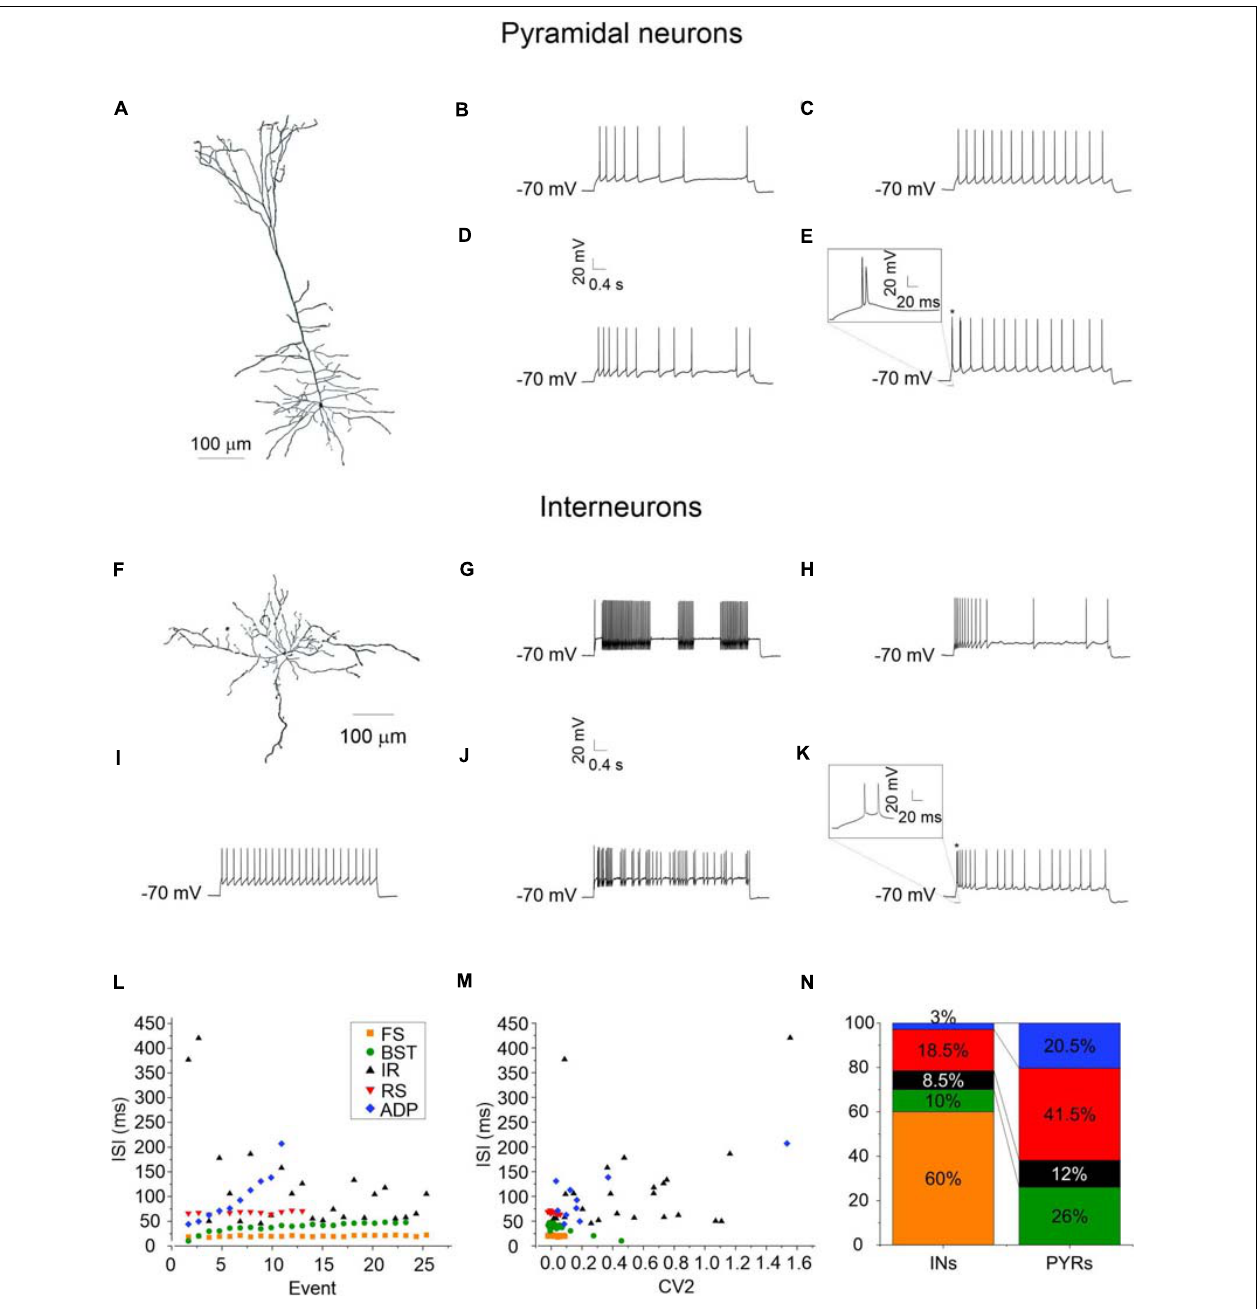
FIGURE 1 | Morphology and firing patterns of pyramidal neurons and GABAergic interneurons of the PRC. (A) Imaris reconstruction of a biocytin-labeled pyramidal neuron of the PRC. (B–E) Firing traces recorded from representative adapting (ADP) (B) , late- and regular-spiking (RS) (C) , irregular (IR) (D) , and bursting (BST; burst magnification in the inset) (E) PRC pyramidal neurons. (F) Imaris reconstruction of a biocytin-labeled perirhinal GABAergic interneuron. (G–K) Firing traces recorded from representative stuttering fast-spiking (FS) (G) , adapting (ADP) (H) , late- and regular-spiking (RS) (I) , irregular (IR) (J) , and bursting (BST; burst magnification in the inset) (K) PRC GABAergic interneurons. (L,M) Inter-spike-interval (ISI) to event plot (L) and inter-spike-interval (ISI) to coefficient of variation (CV2) plot (M) showing the behavior of five representative cells, one for each type of firing patter identified in the PRC. (N) Percentage of each type of discharge in PRC pyramidal cells ( N = 128) and GABAergic interneurons ( N = 70),